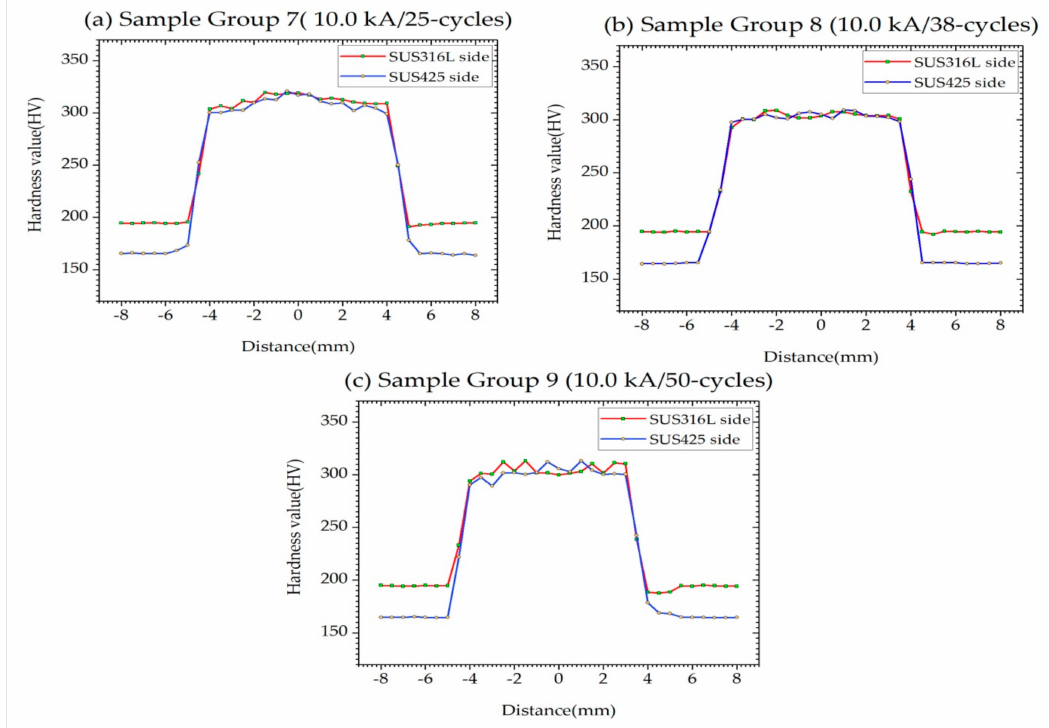
Figure 10. Micro hardness profiles of welded specimens given a 10.0 kA weld current: ( a ) 25; ( b ) 38; ( c ) 50-cycle welding